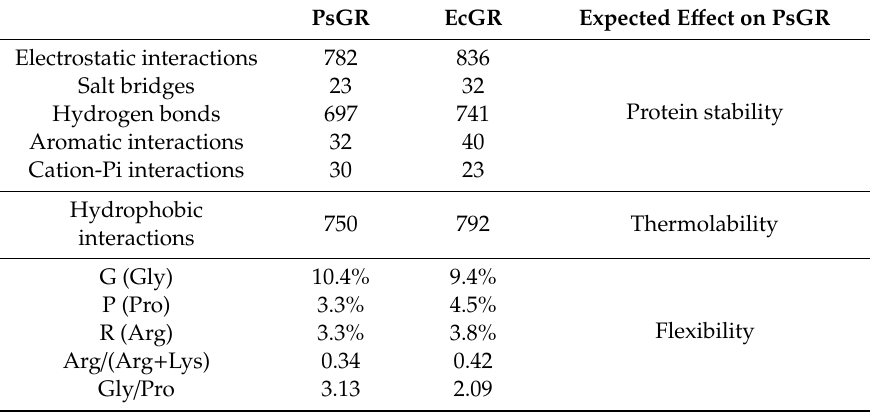
Figure 2. Three-dimensional (3D) structure model of PsGR (purple) superimposition with EcGR (blue, PDB ID: 1GET). The FAD and NADPH binding motifs are indicated as stick models colored in yellow and green, respectively. Table 1. Comparison of structural adaptation features between PsGR and EcGR.